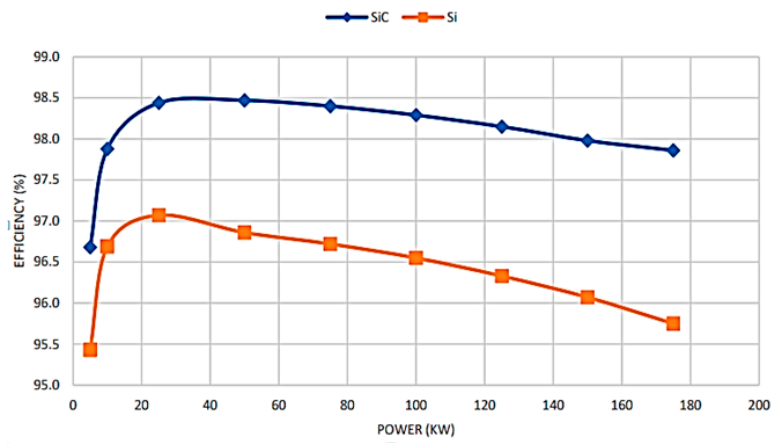
Figure 8. Si- and SiC-based high-power o ff -board charging system e ffi ciency map.